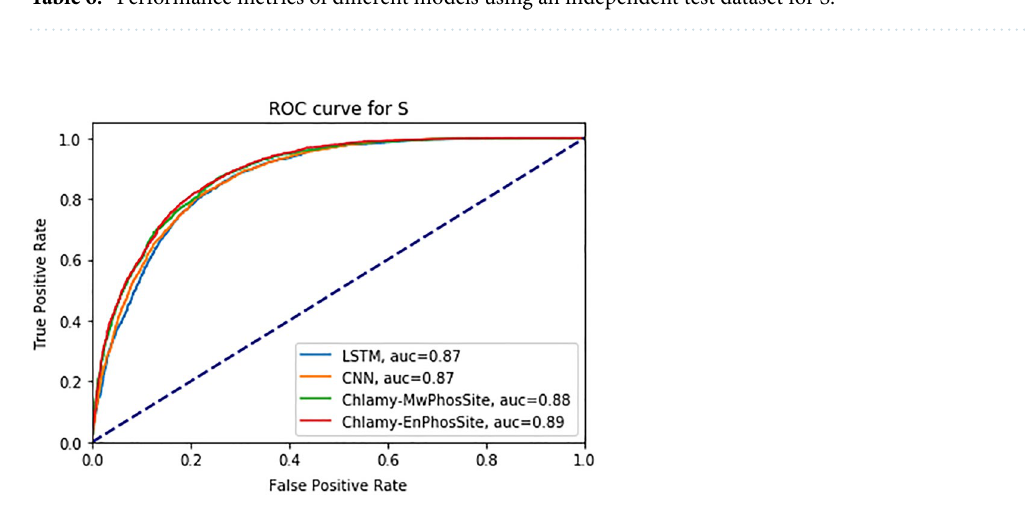
Figure 4. ROC curve for different DL models for